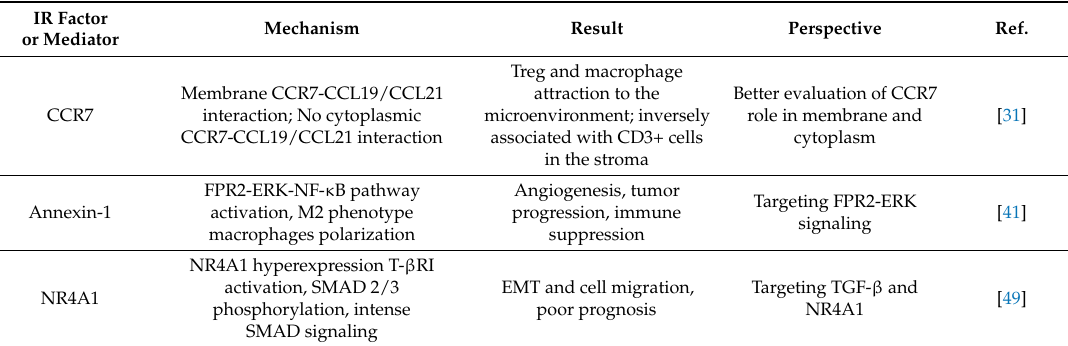
Table 2. Relationships of the Immune Response (IR) with Tumor Growth and